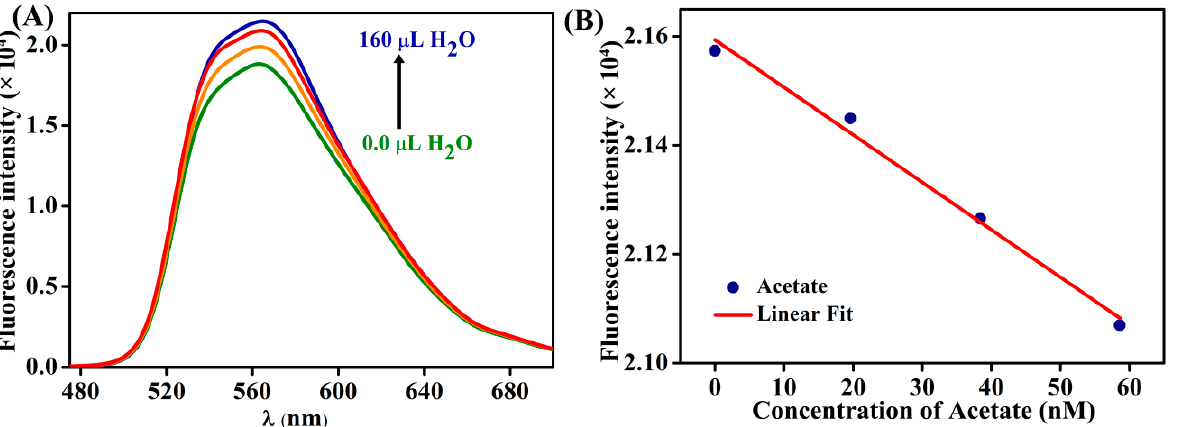
Figure 5. ( A ) Regeneration of fluorescence emission of QZ following titration with H 2 O at 25 °C. ( B ) The sensitivity plot indicates that the limit of detection is at the ppb level.